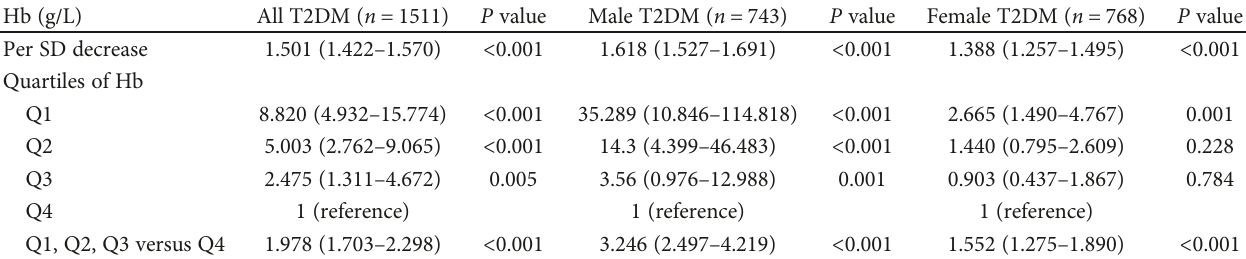
Table 2: Association between quartiles of Hb with DPN in di ff erent groups of T2DM